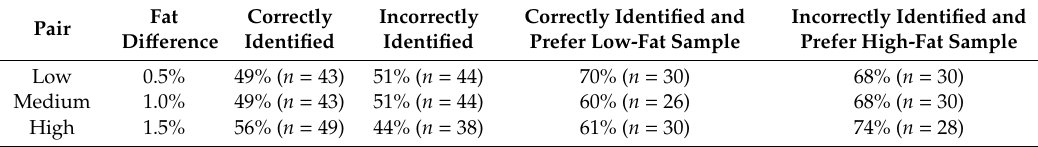
Table 5. Fattiness sensitivity measured in milk samples ( n = 87 subjects).